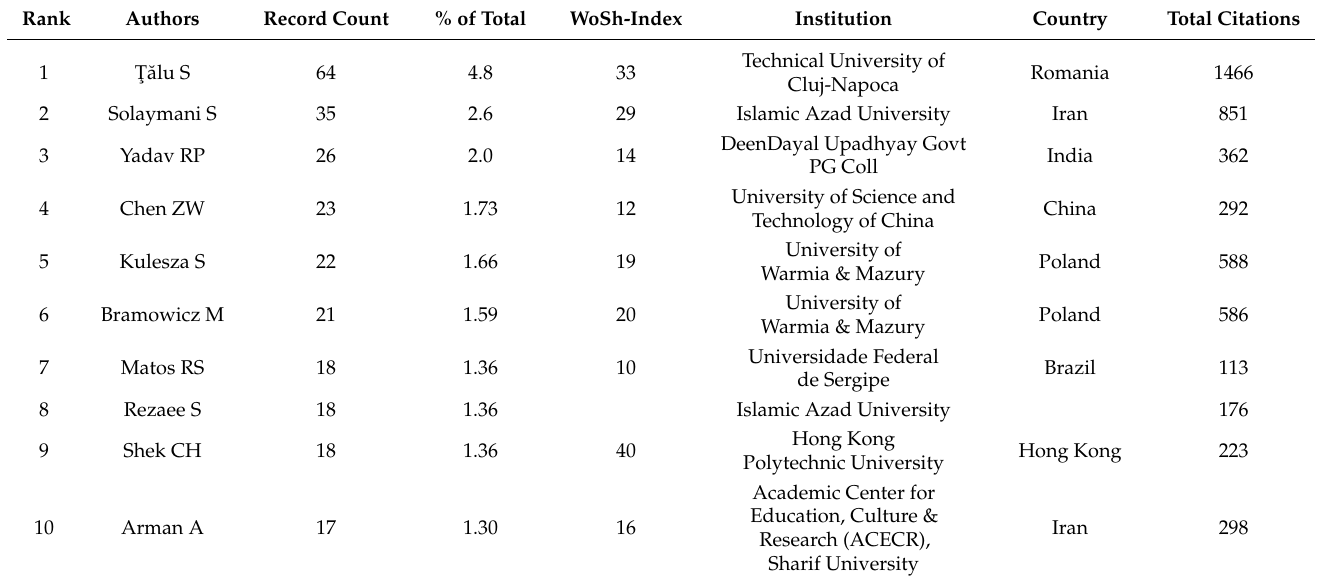
Table 8. Top 10 most influential authors in fractal theory in thin